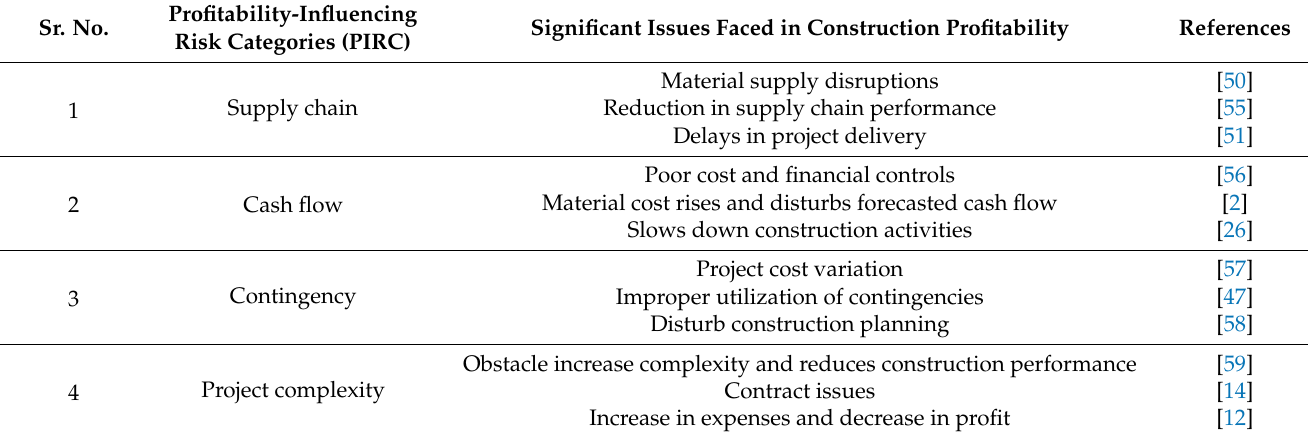
Table 2. The PIRFs have specific natures and causes, whereas the PIRCs have combinations of different factors, and their corresponding issues, under larger categories. This study analyzes the causal interdependencies of PIRFs on the PIRCs in construction projects. Table 2. Profitability-influencing risk categories (PIRC) and issues. Sr.